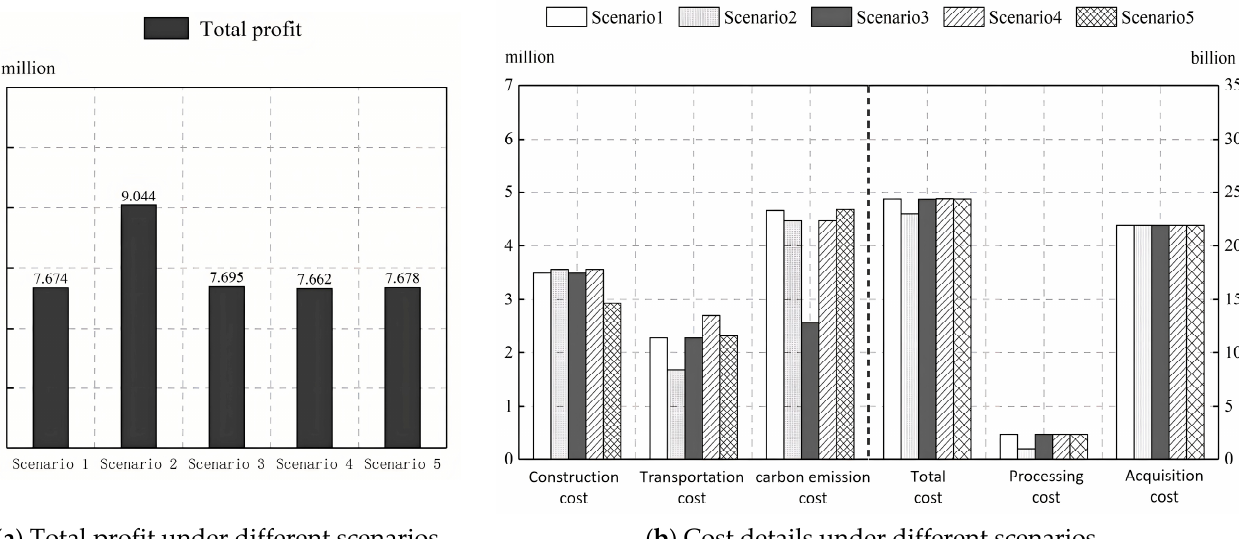
Figure 7. Total profit and cost details under different scenarios.